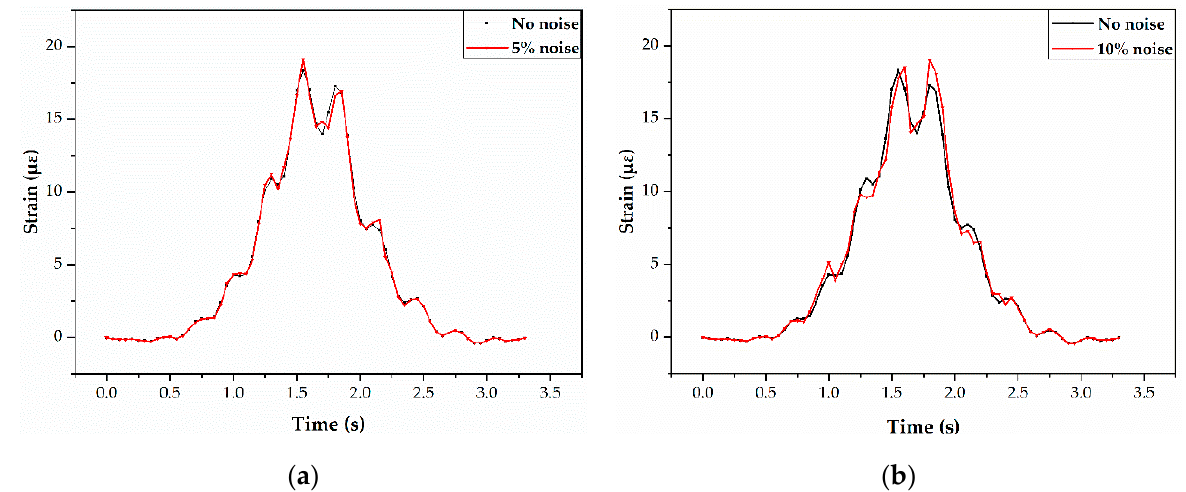
Figure 10. The mid-span strain time history of 3# beam with ( a ) 5% noise, ( b ) 10% noise.